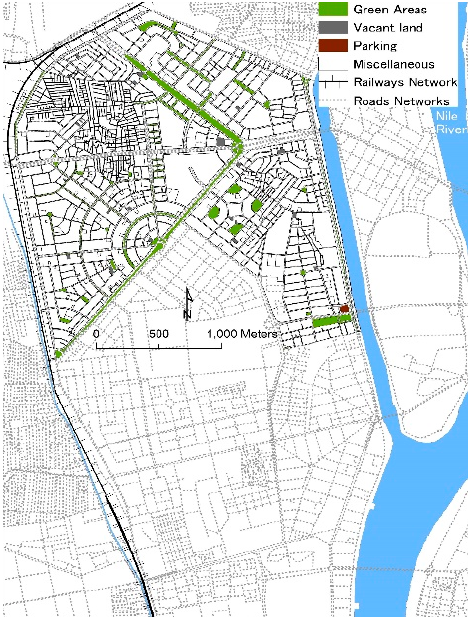
Figure 11. Open spaces in Agouza.